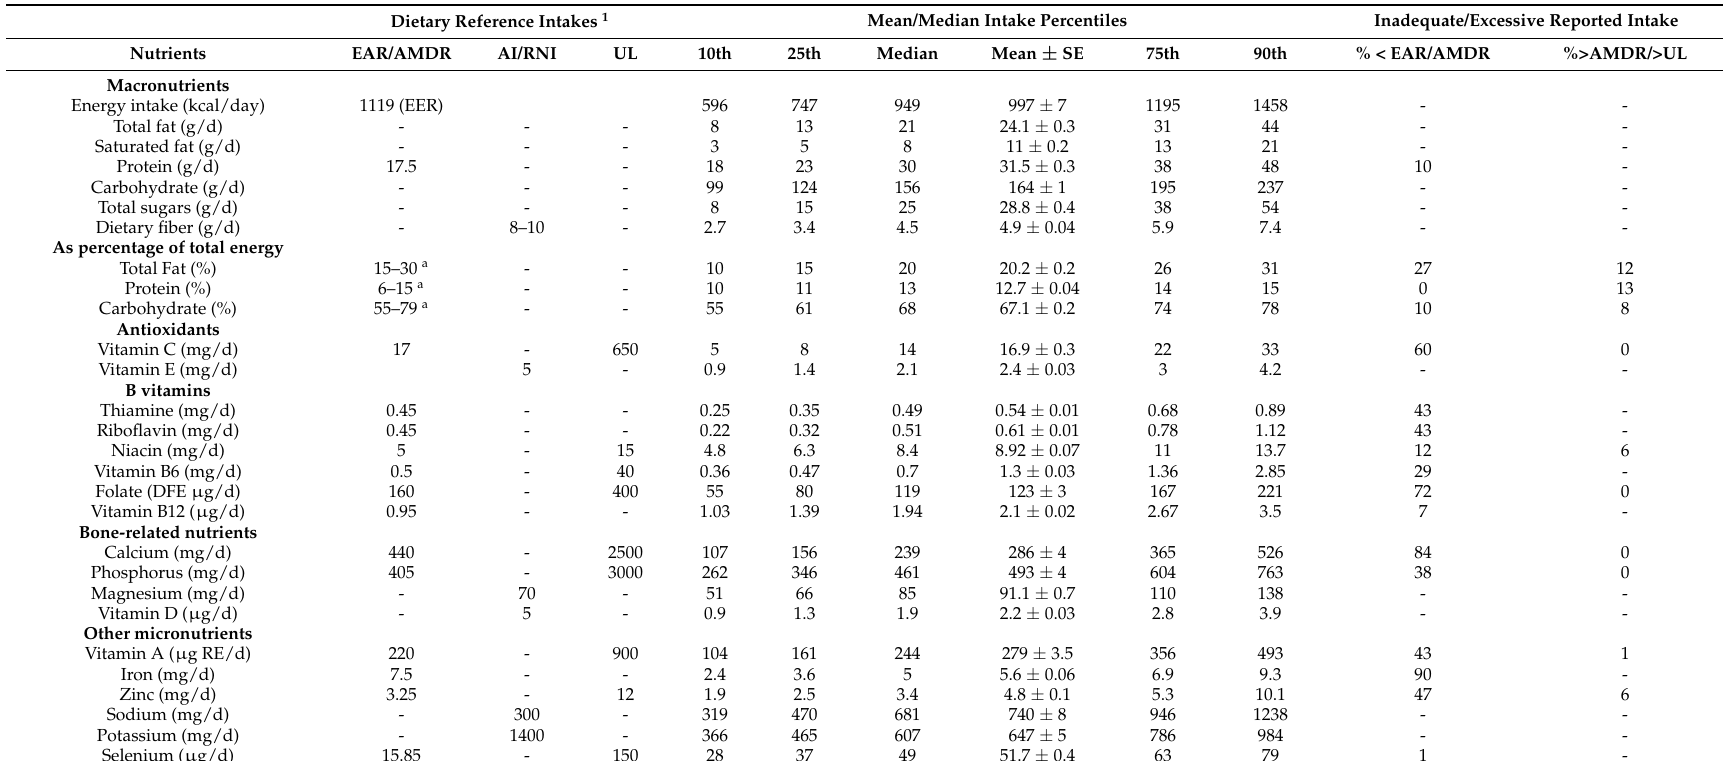
Table 9. Usual energy and nutrient intakes from food and beverages for Filipino young children aged 36–59.9 months ( n =